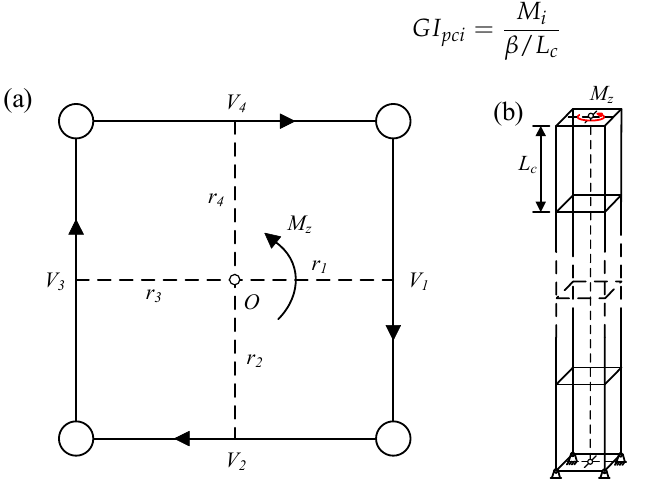
Figure 6. Torsion diagram ( a ) of a typical cross-section in the equivalent straight truss ( b ) consider- ing the shear deformation of chords.